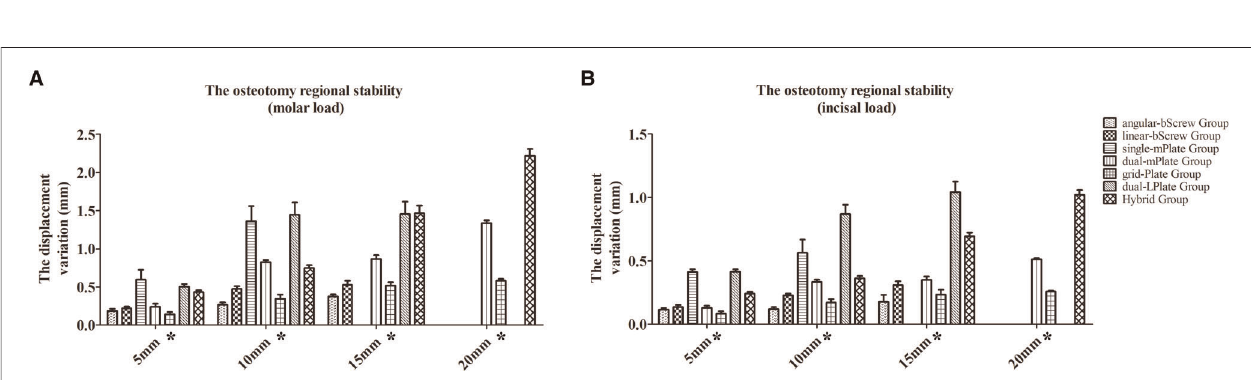
FIGURE 3 | Results of the osteotomy regional stability after different fi xation methods under molar ( A ) and incisal ( B ) load conditions. * p